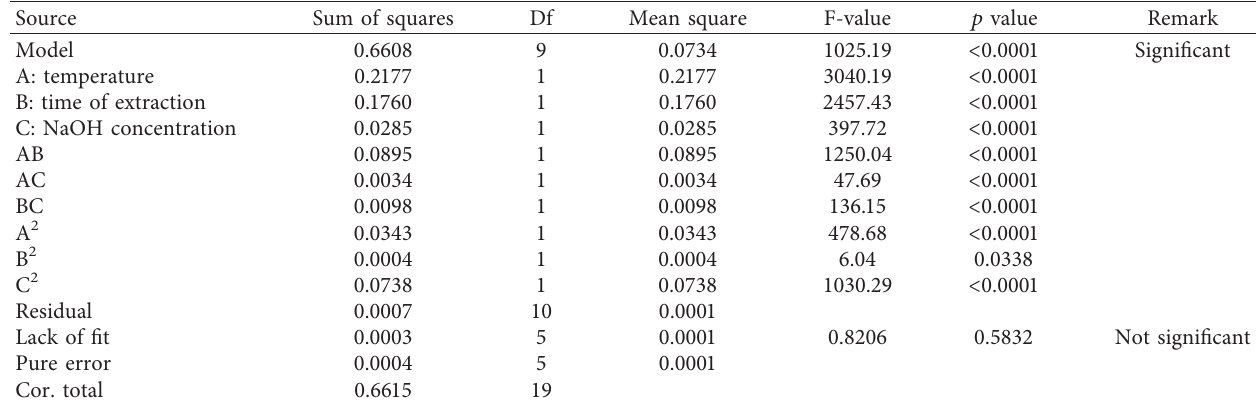
Table 6: ANOVA fit for nicotine